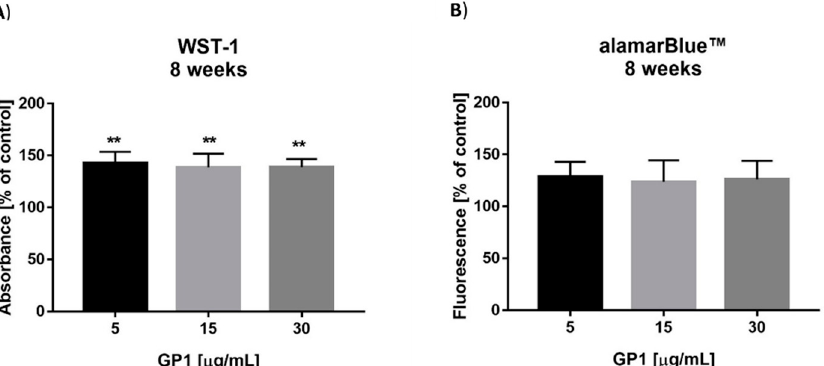
Figure 2. Long-term cytotoxic effect of graphene GP1 at concentrations of 5, 15, and 30 µg/mL on A549 cells during eight weeks as measured by cell metabolic assay—( A ) WST-1, ( B ) cell metabolic assay—alamarBlue TM . Data (optical density, cell count) represent the mean expressed as percentage of control (0 mM) ± SD of the three different experiments. Statistical significance was evaluated with One-way ANOVA Dunnett’s multiple comparisons test. Statistically significant increase of values compared to controls ** p < 0.01.